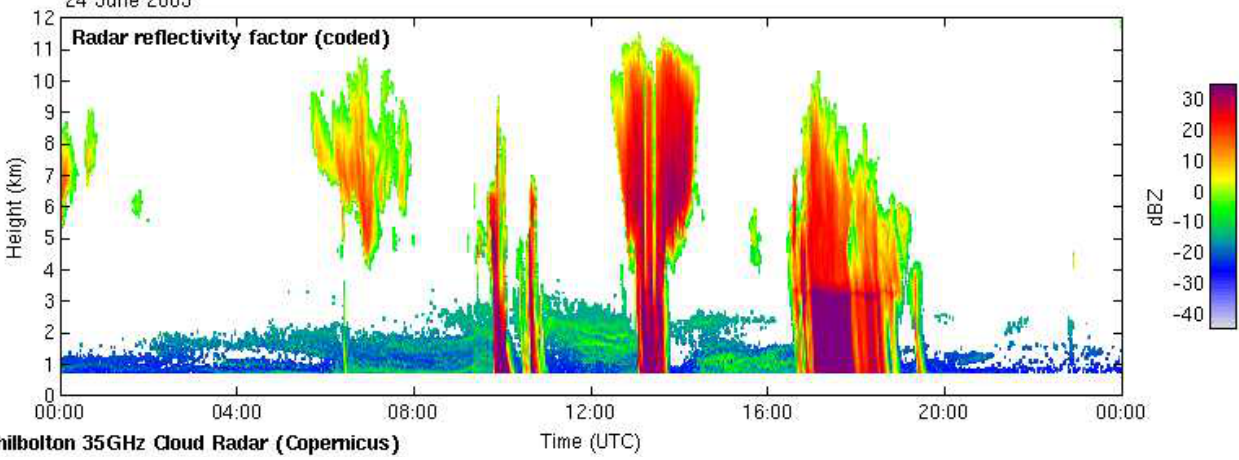
Fig. 9. Time height cross section of reflectivity measured the 35GHz cloud radar at Chilbolton. (from cloudnet website: www.met.rdg.ac.